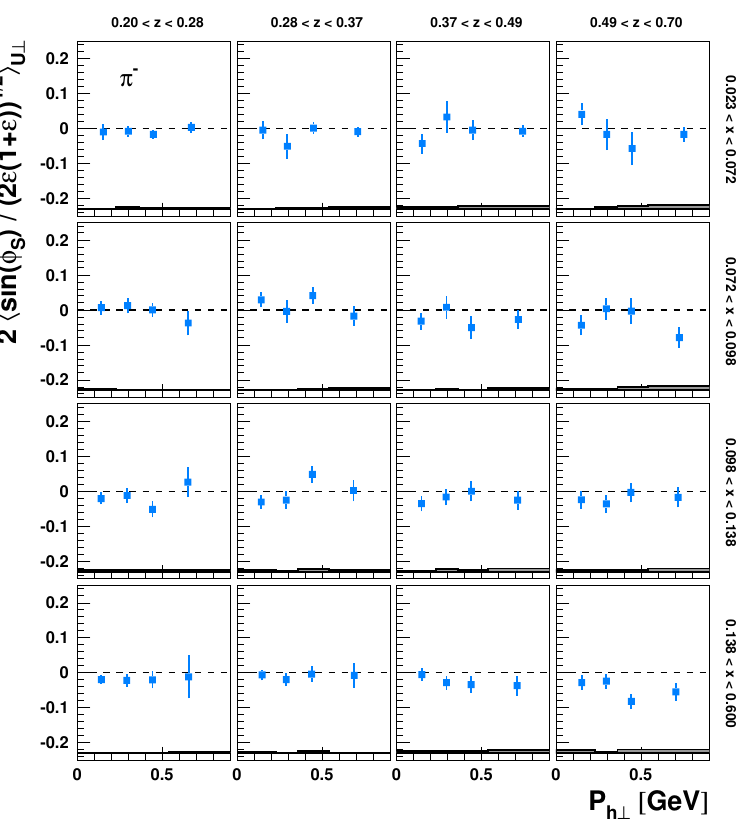
p Figure 26 . The 2 h sin( φ S ) / 2 (cid:15) (1+ (cid:15) ) i Fourier amplitudes for π − extracted simultaneously in U ⊥ bins of x , z , and P h ⊥ , presented as a function of P h ⊥ . Systematic uncertainties are given as bands, not including the additional scale uncertainty of 7.3% due to the precision of the target-polarization